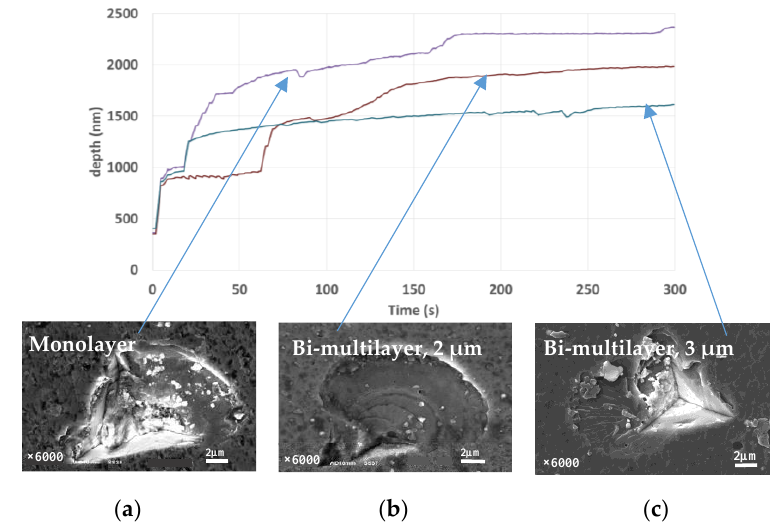
Figure 4. Impact fatigue fracture resistance at 25–30 mN, 300 s for the studied coatings: ( a ) monolayer, 3 µm; ( b ) bi-multilayer, 2 µm; ( c ) bi-multilayer, 3 µm.